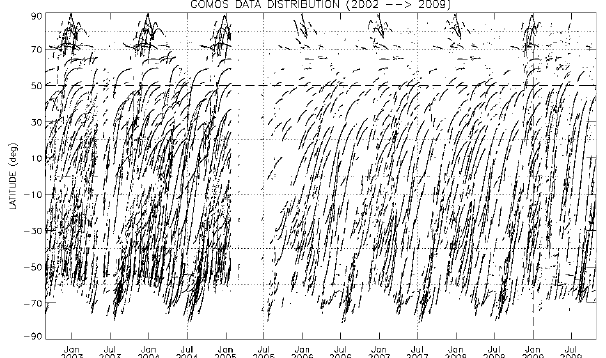
Fig. 9. Latitude distribution of all night time occultations performed by GOMOS (2002–2009). One arc represents many successive occultations of the same star, moving in latitude from one orbit to the next. The coverage was somewhat reduced after the 2005 malfunction of the Steering Mirror Mechanism. Polar latitudes are reached only during winter time.